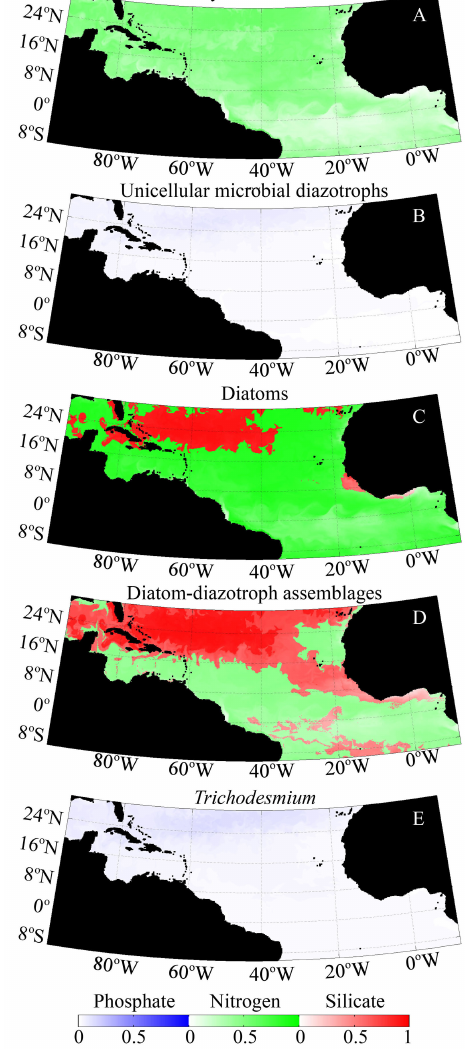
Figure 11. Nutrient limitations. Color intensity represents the de- gree of nutrient limitation experienced by each model phytoplank- ton taxa; a value of 0.75 indicates that max growth is decreased by 75% due to nutrient limitation. Color indicates the limiting nutrient (blue-phosphate, green-nitrate, red-silicate). Since DDAs are not ul- timately limited by DIN, but can grow faster in its presence, we de- termined the limiting nutrient by calculating the partial derivative of growth with respect to each